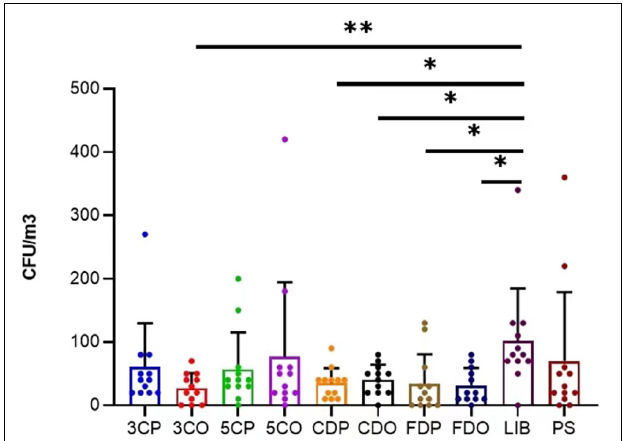
FIGURE 3 | Variation of annual average fungal concentration (CFU/m 3 ) at different sampling sites. ∗∗ P < 0.01, ∗ P < 0.05. 3CP, Canteen 3 Peak; 3CO, Canteen 3 Off-peak; 5CP, Canteen 5 Peak; 5CO, Canteen 5 Off-peak; CDP, Chinese student Dorm Peak; CDO, Chinese student Dorm Off-peak; FDP, Foreign student Dorm Peak; FDO, Foreign student Dorm